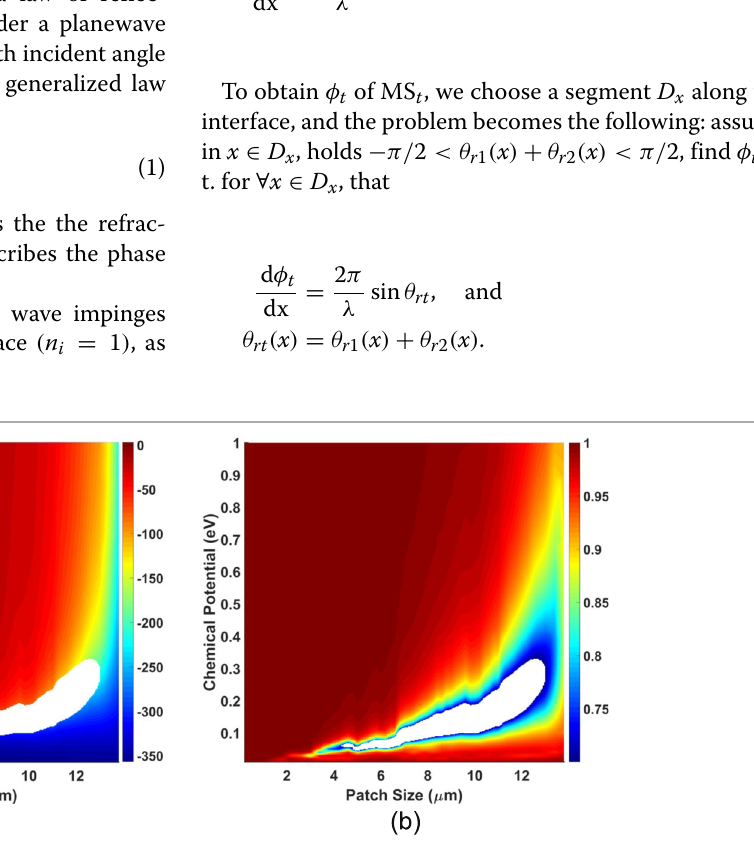
combine the functionalities of vortex wave generation and wave deflection by anomalous reflection in this paper.